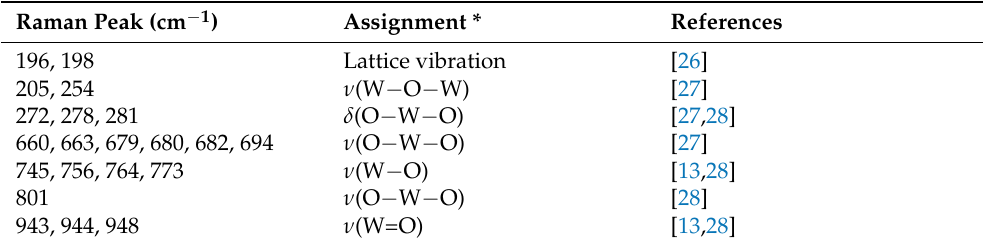
Figure 2. Raman spectra ( a ) and deconvoluted Raman spectra ( b – f ) of as-synthesized WO 3- x aggre- gates. The data in the insets are the positions corresponding to Raman peaks. Table 3. Assignment of Raman peaks in Figure